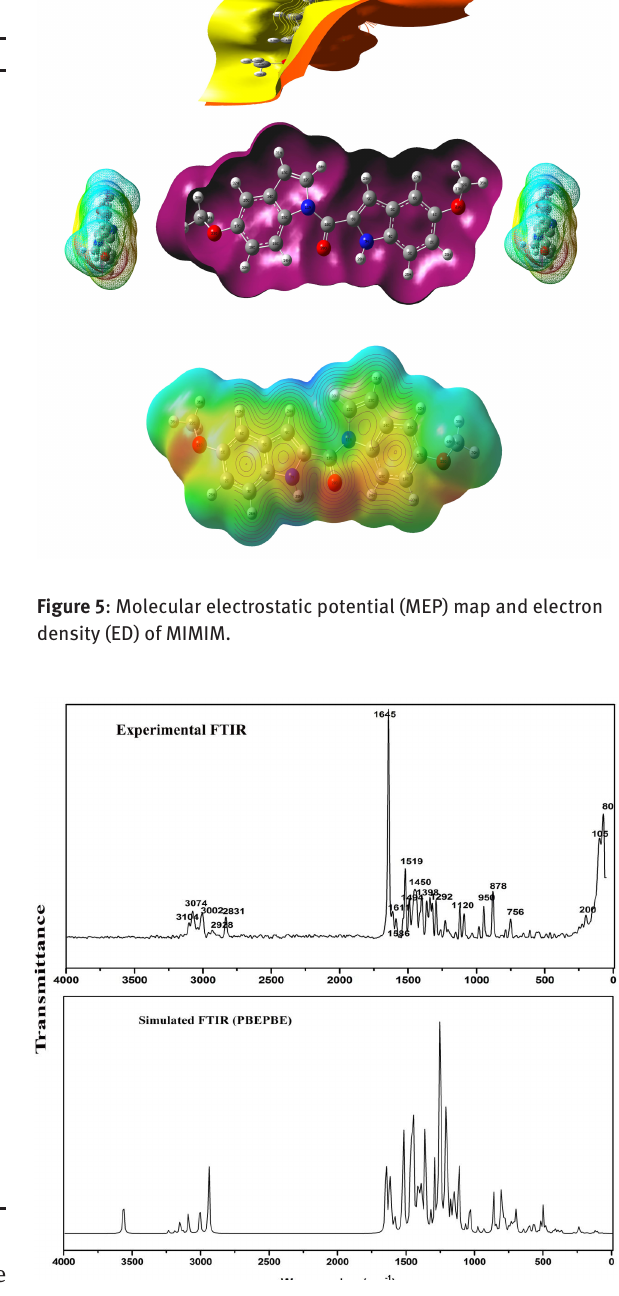
Table 3 : Theoretical electronic absorption spectra of MIMIM in various solvents, calculated by TD-DFT/PBEPBE method. Calculated parameters are absorption wavelength λ (nm), excitation energies E (eV) and oscillator strengths ( f ).